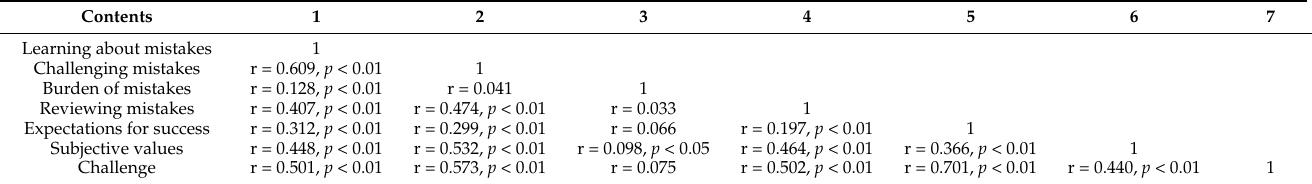
Table 4. Analysis of correlation between